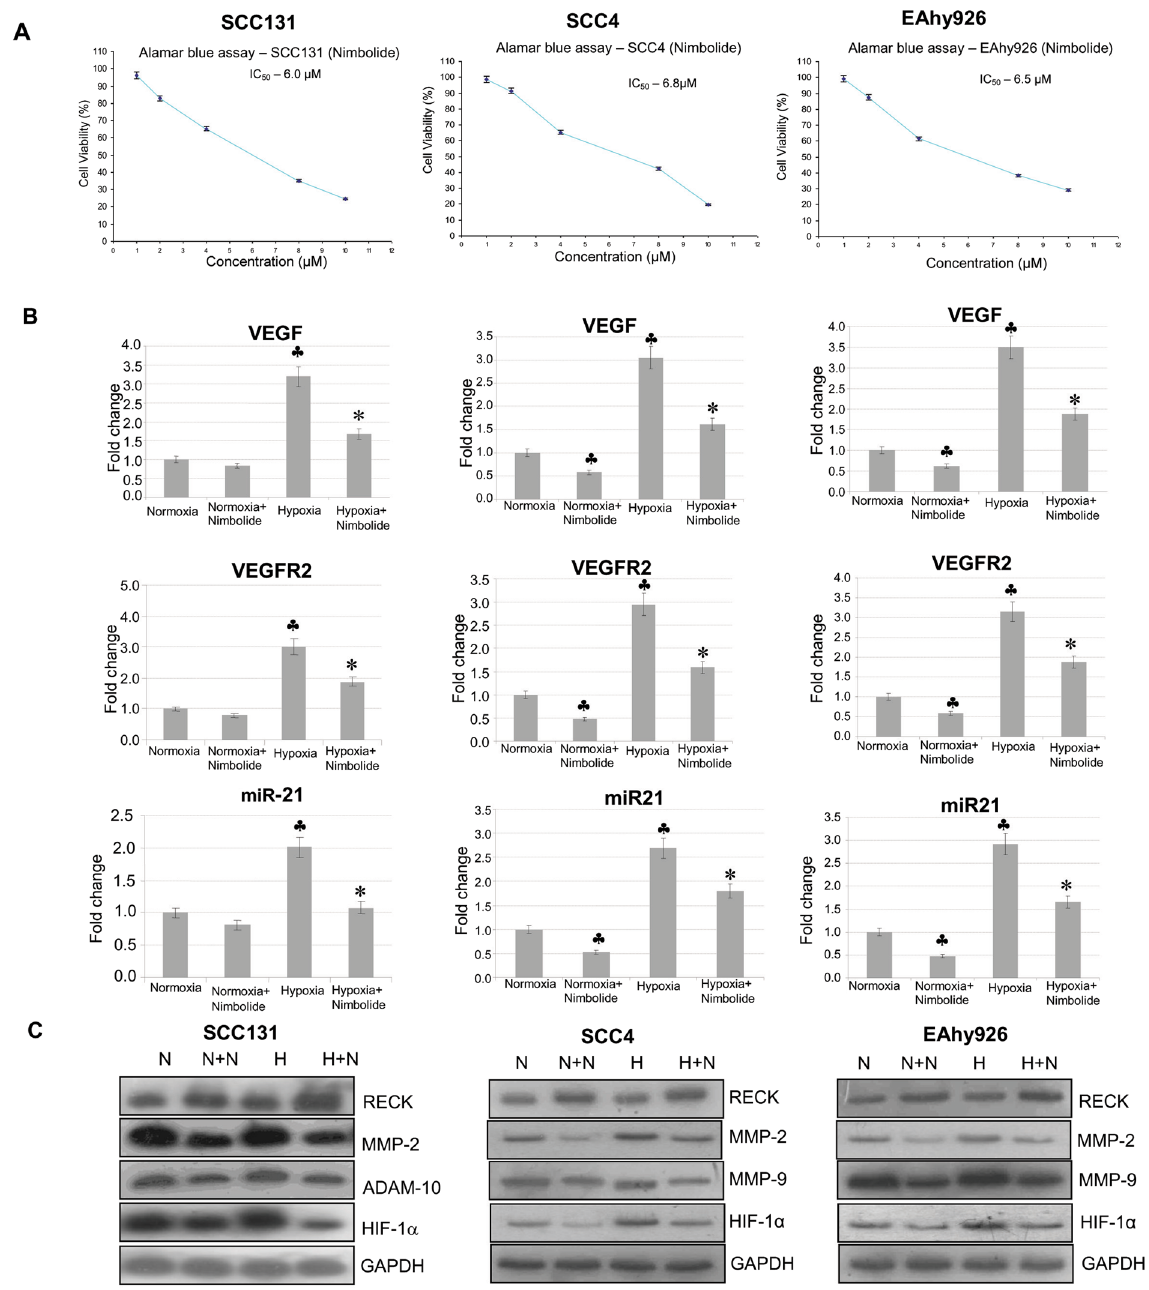
Figure 6. Nimbolide activates RECK and inhibits pro-invasive and pro-angiogenic molecules in a cellular context. ( A ) IC 50 value for nimbolide in SCC131, SCC4 and EAhy926 cells (Alamar Blue assay). ( B ) Transcript expression level of VEGF, VEGFR2, and miR-21 by quantitative RT-PCR in SCC131, SCC4 and EAhy926 cell lines. Data are the mean ± SD of three independent experiments (N = 3). ♣ p < 0.001 versus normoxia. * p < 0.001versus hypoxia. ( C ) Immunoblotting was performed to analyse the expression of RECK, MMP- 2, ADAM-10 and HIF-1 α in the absence or presence of nimbolide (1 µ m) under normoxic and hypoxic